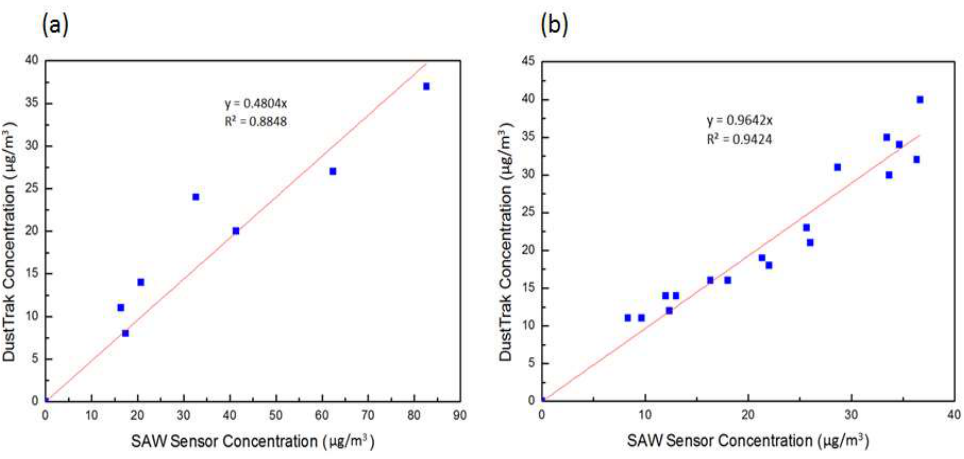
Figure 9. ( a ) Aerosol test of an SH-SAW sensor with no PM2.5 separator. ( b ) Aerosol test of SH-SAW sensor with a cyclone separator (0.2 mL).